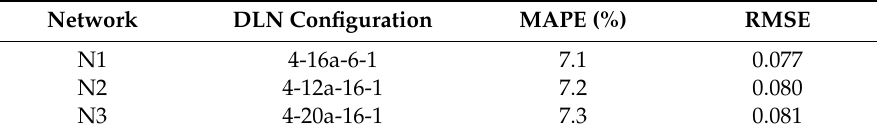
Table 4. Estimation errors for the different DLN configurations.